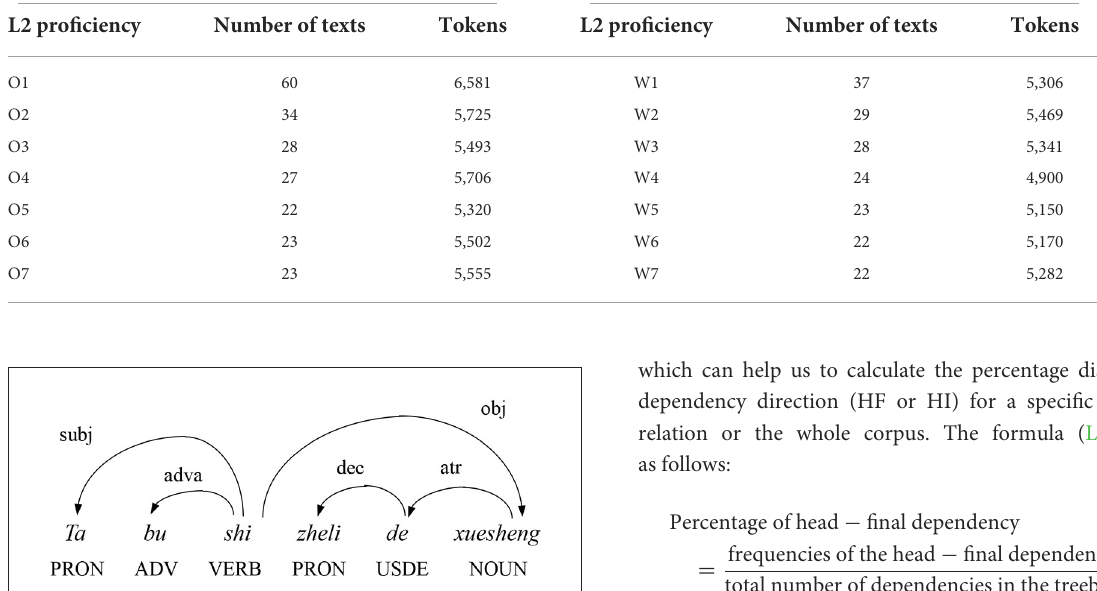
FIGURE1 Dependency structure of the sample Chinese sentence Ta bu shi zheli de xuesheng (“He’s not a student